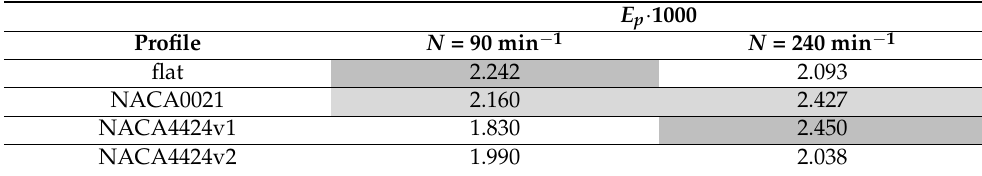
Table 6. Efficiency of